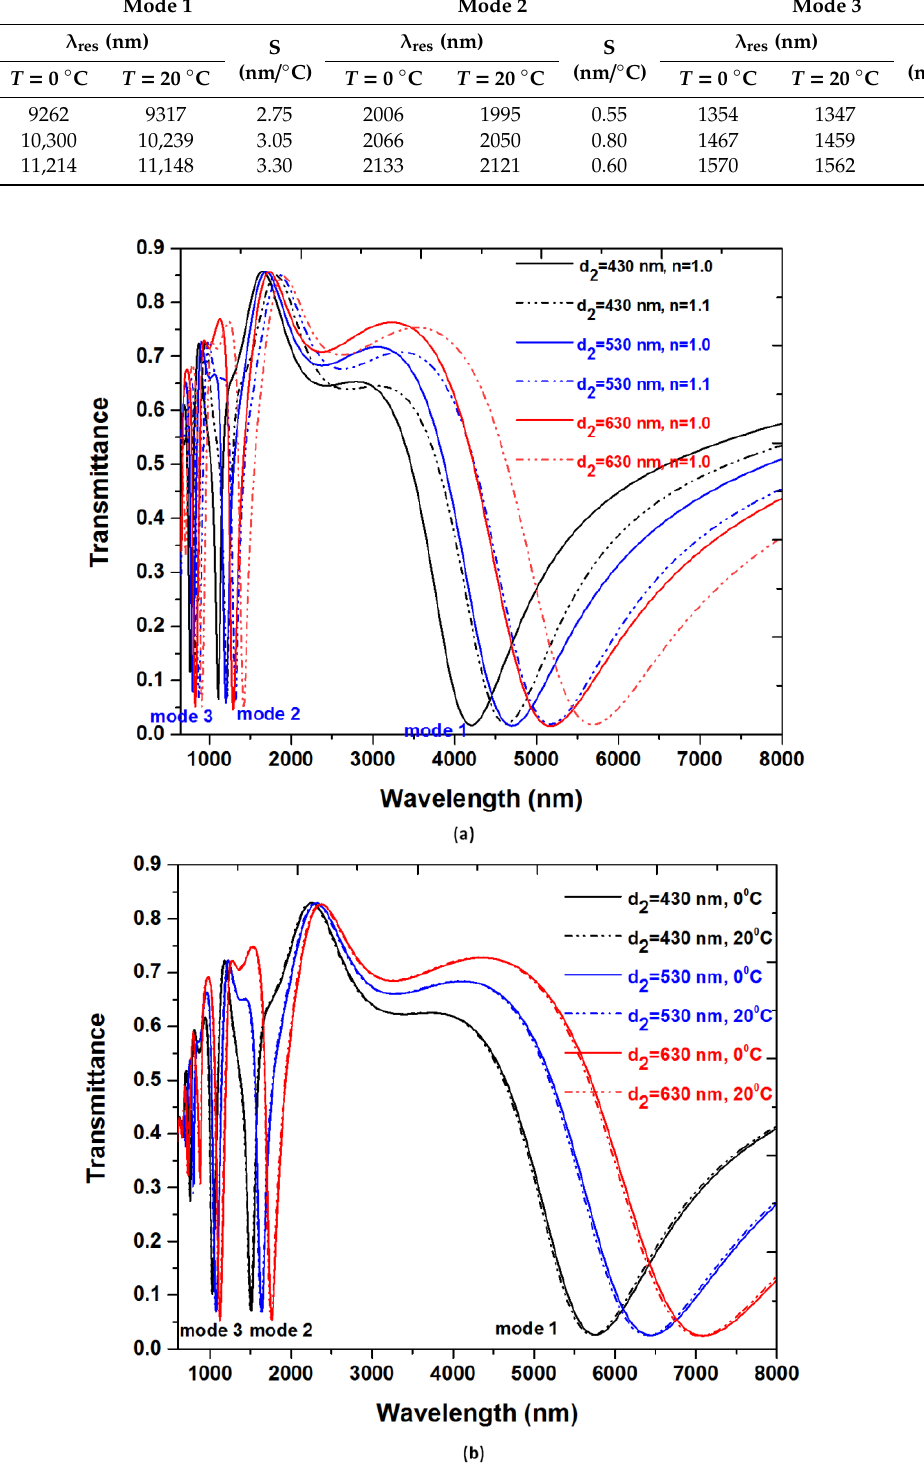
Figure 7. Transmittance spectra as a function of the ( a ) RI ( n = 1.0 and 1.2) and ( b ) ambient temperature ( T = 0 ◦ C and 20 ◦ C) for di ff erent d 2 (i.e., 430 nm, 530 nm and 630 nm) of the MIM waveguides. The other parameters are kept the same as used in Figure